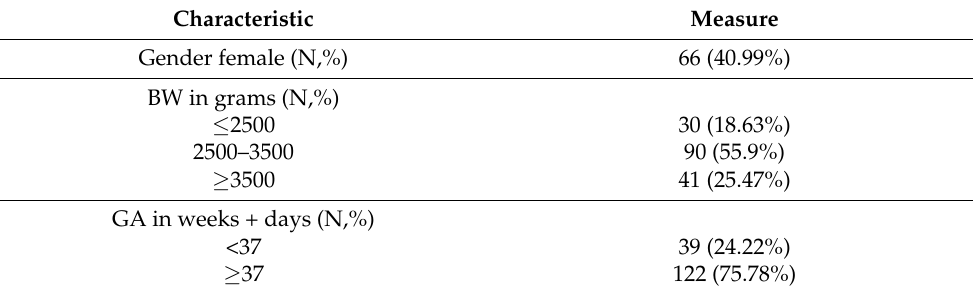
Table 2. Baseline characteristics of the neonates.